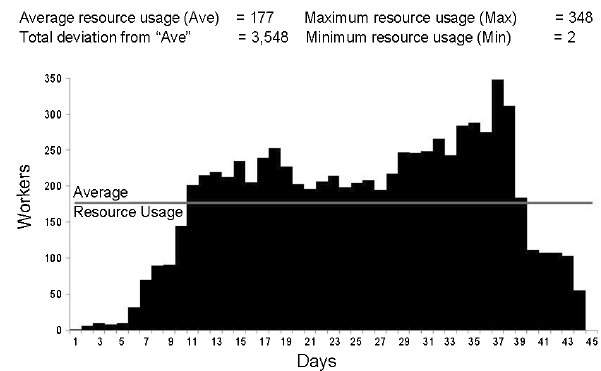
Fig. 5. Resource histogram before resource